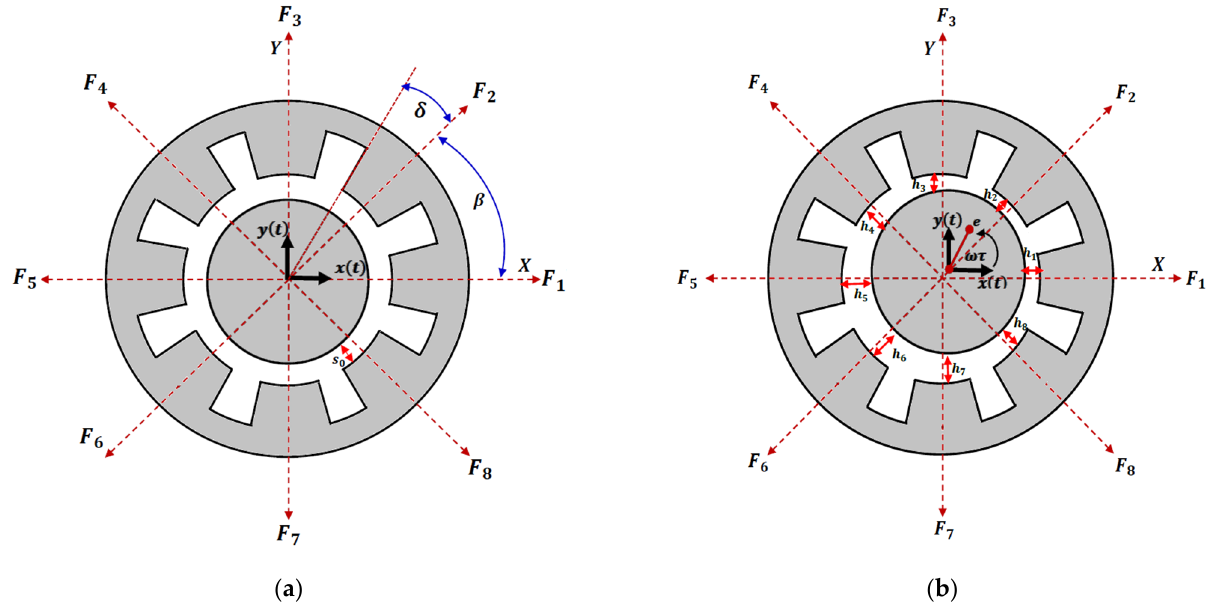
Figure 2. ( a ) Jeffcott-rotor system and magnetic bearings actuator at the nominal position. ( b ) Jeffcott-rotor system and magnetic bearings actuator at small displacements 𝑥(𝜏) and 𝑦(𝜏) away from the nominal position.